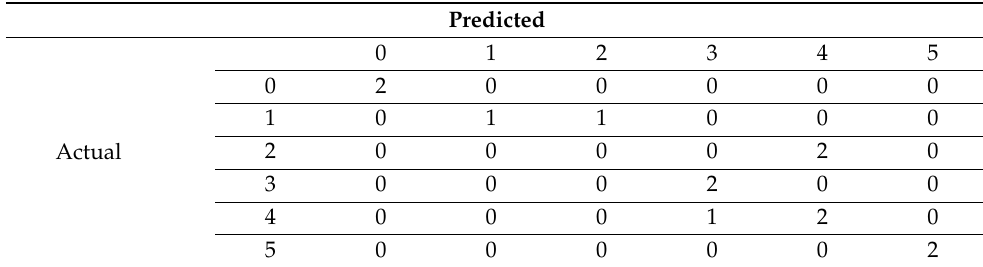
Table 4. Proposed Method. Accuracy: 69.23%.